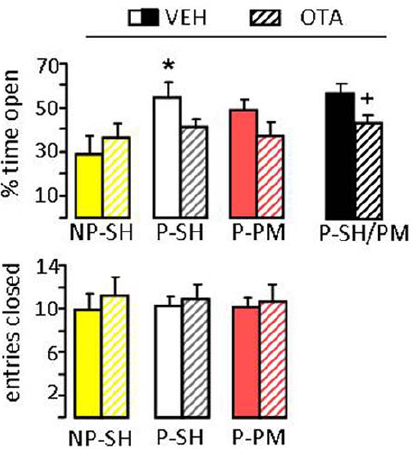
Figure 4. Effects of an oxytocin receptor antagonist (OTA) on anxiety-related behavior in female rats. Female rats were classified into three groups: (i) non-primed single-housed (NP-SH) (ii) primed single-housed (P-SH) and (iii) primed paced-mated (P-PM). NP and P rats were infused with either a selective OTA (0.75 m g/5 m l, intracerebroventricular, hatched bars) or vehicle (plane bars) into the lateral ventricle immediately after 30 min of PM or SH, and 30 min before testing on the plusmaze. A significant effect of OTA on anxiety- related behavior indicated by the percent time spent on the open arms of the maze was found after combining behavioral data from both primed groups (right, black columns). Locomotion reflected by the number of closed arm entries was not altered by any treatment. Data represent means + S.E.M. * P , 0.05 versus vehicle-treated non-primed SH females, + P , 0.05 versus vehicle-treated groups (combined primed single-housed and paced-mated groups treated with either vehicle or